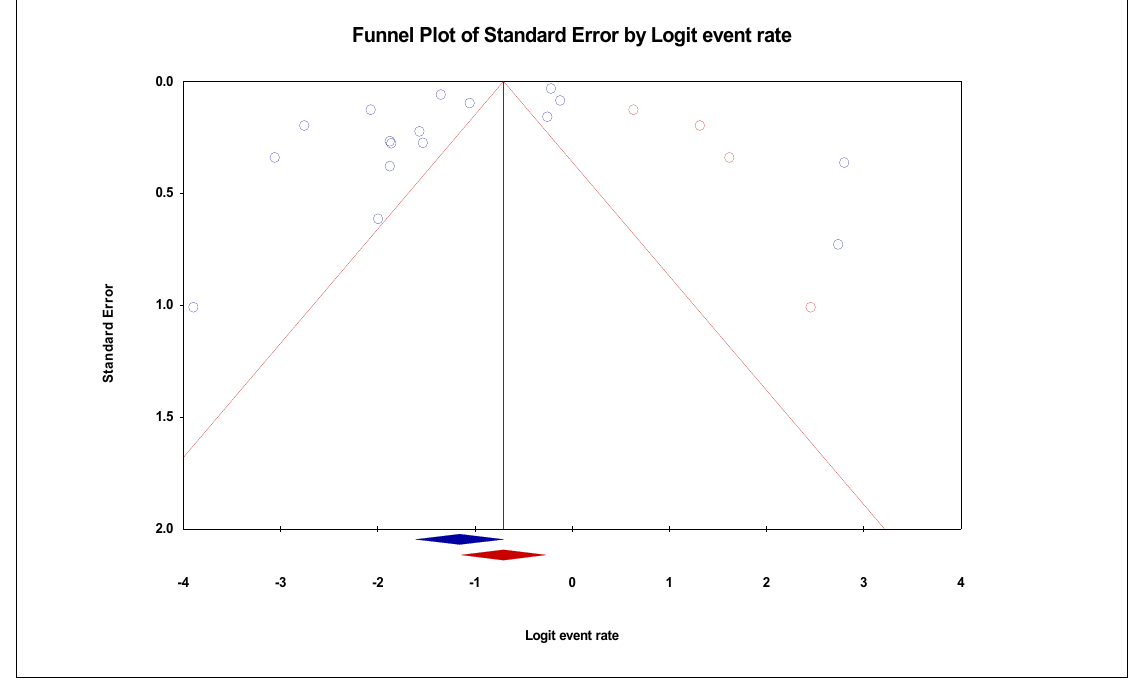
Figure 5. Funnel plot showing 4 added studies (in Red) in the Trim-and-Fill method reporting the prevalence of VRE in in poultry in Malaysia. This method simply looks for missing studies that will eventually eliminate bias. In this case, 4 studies will have to be added to the right side for the plot to be symmetrical.